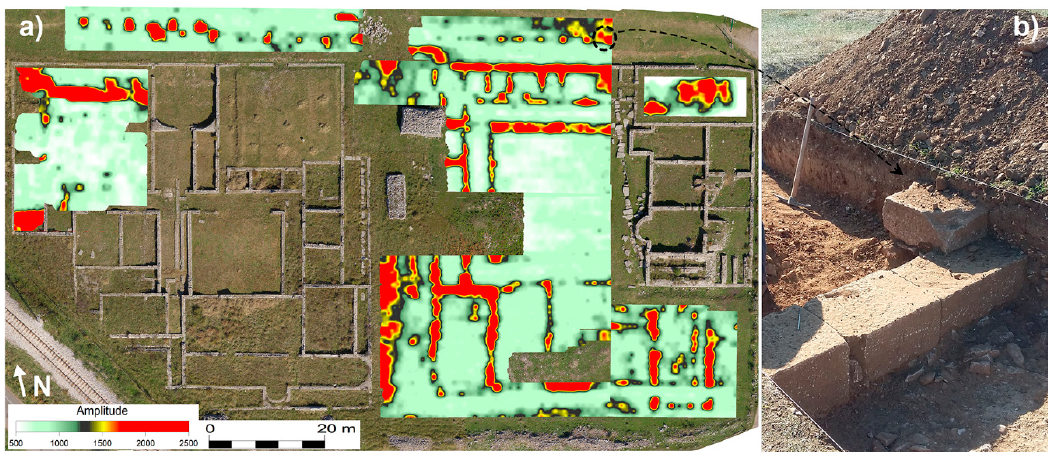
Figure 12. Doclea: GPR time slice relative to 14–18 ns between the thermae overlapped on the photogrammetric image (modified by [75]) ( a ) and a picture of the excavated base of column laying on the southern border of the road ( b ).